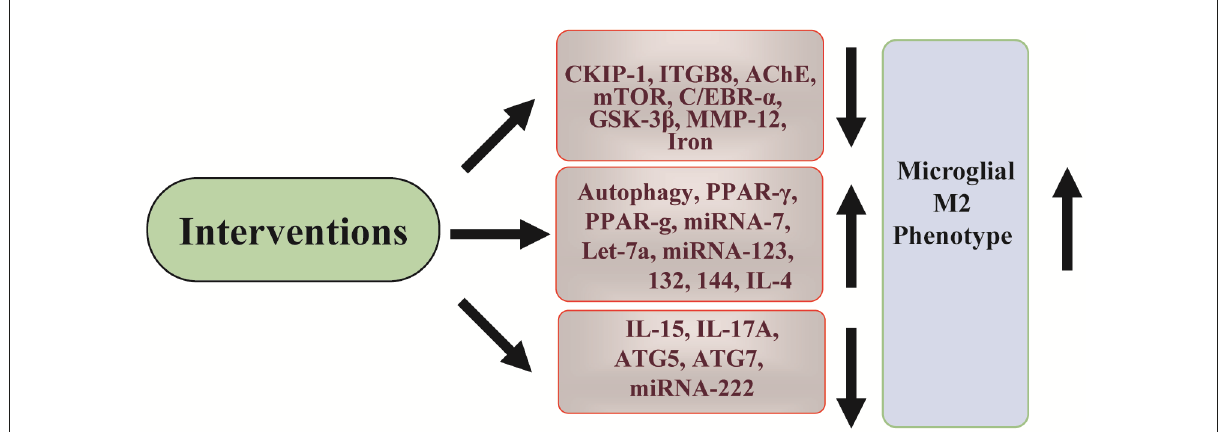
FIGURE3 Summary of targets for ICH microglial polarization. Different available interventions can be used to inhibit microglial neuroinflammation. The targets cover signaling pathway proteins, single proteins, genes, and miRNAs. Through modulating these targets, the M1 phenotype of microglia can be switched to the M2